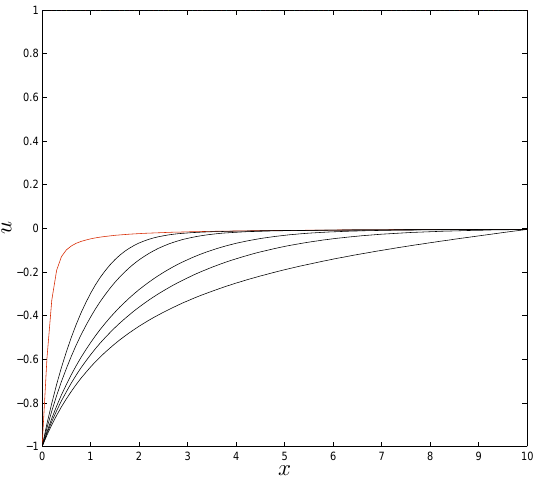
Figure 5: Graph of the numerical solution of QP in the ( x , u = v ) plane for u b = −1 and u + = 0 at times t = 5, 10, 15, 20, 25 and 30 . We note that the exact SS is shown via the red line at t > 30 .